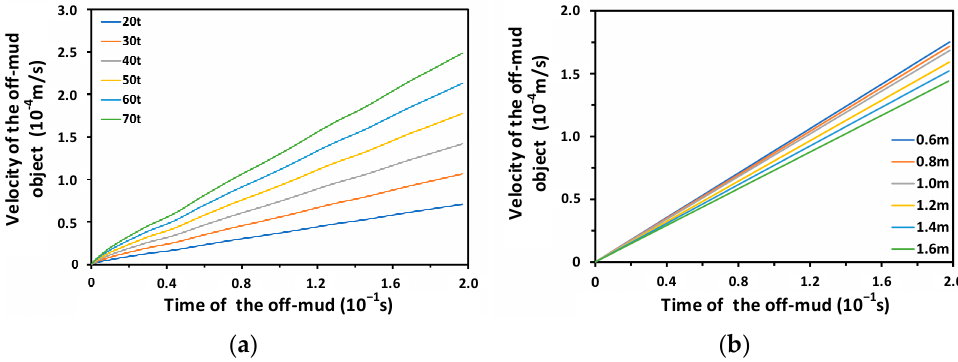
Figure 18. Effects of lifting force and burial depth on velocity: ( a ) burial depth, 1.6 m; ( b ) lifting force, 50 t.